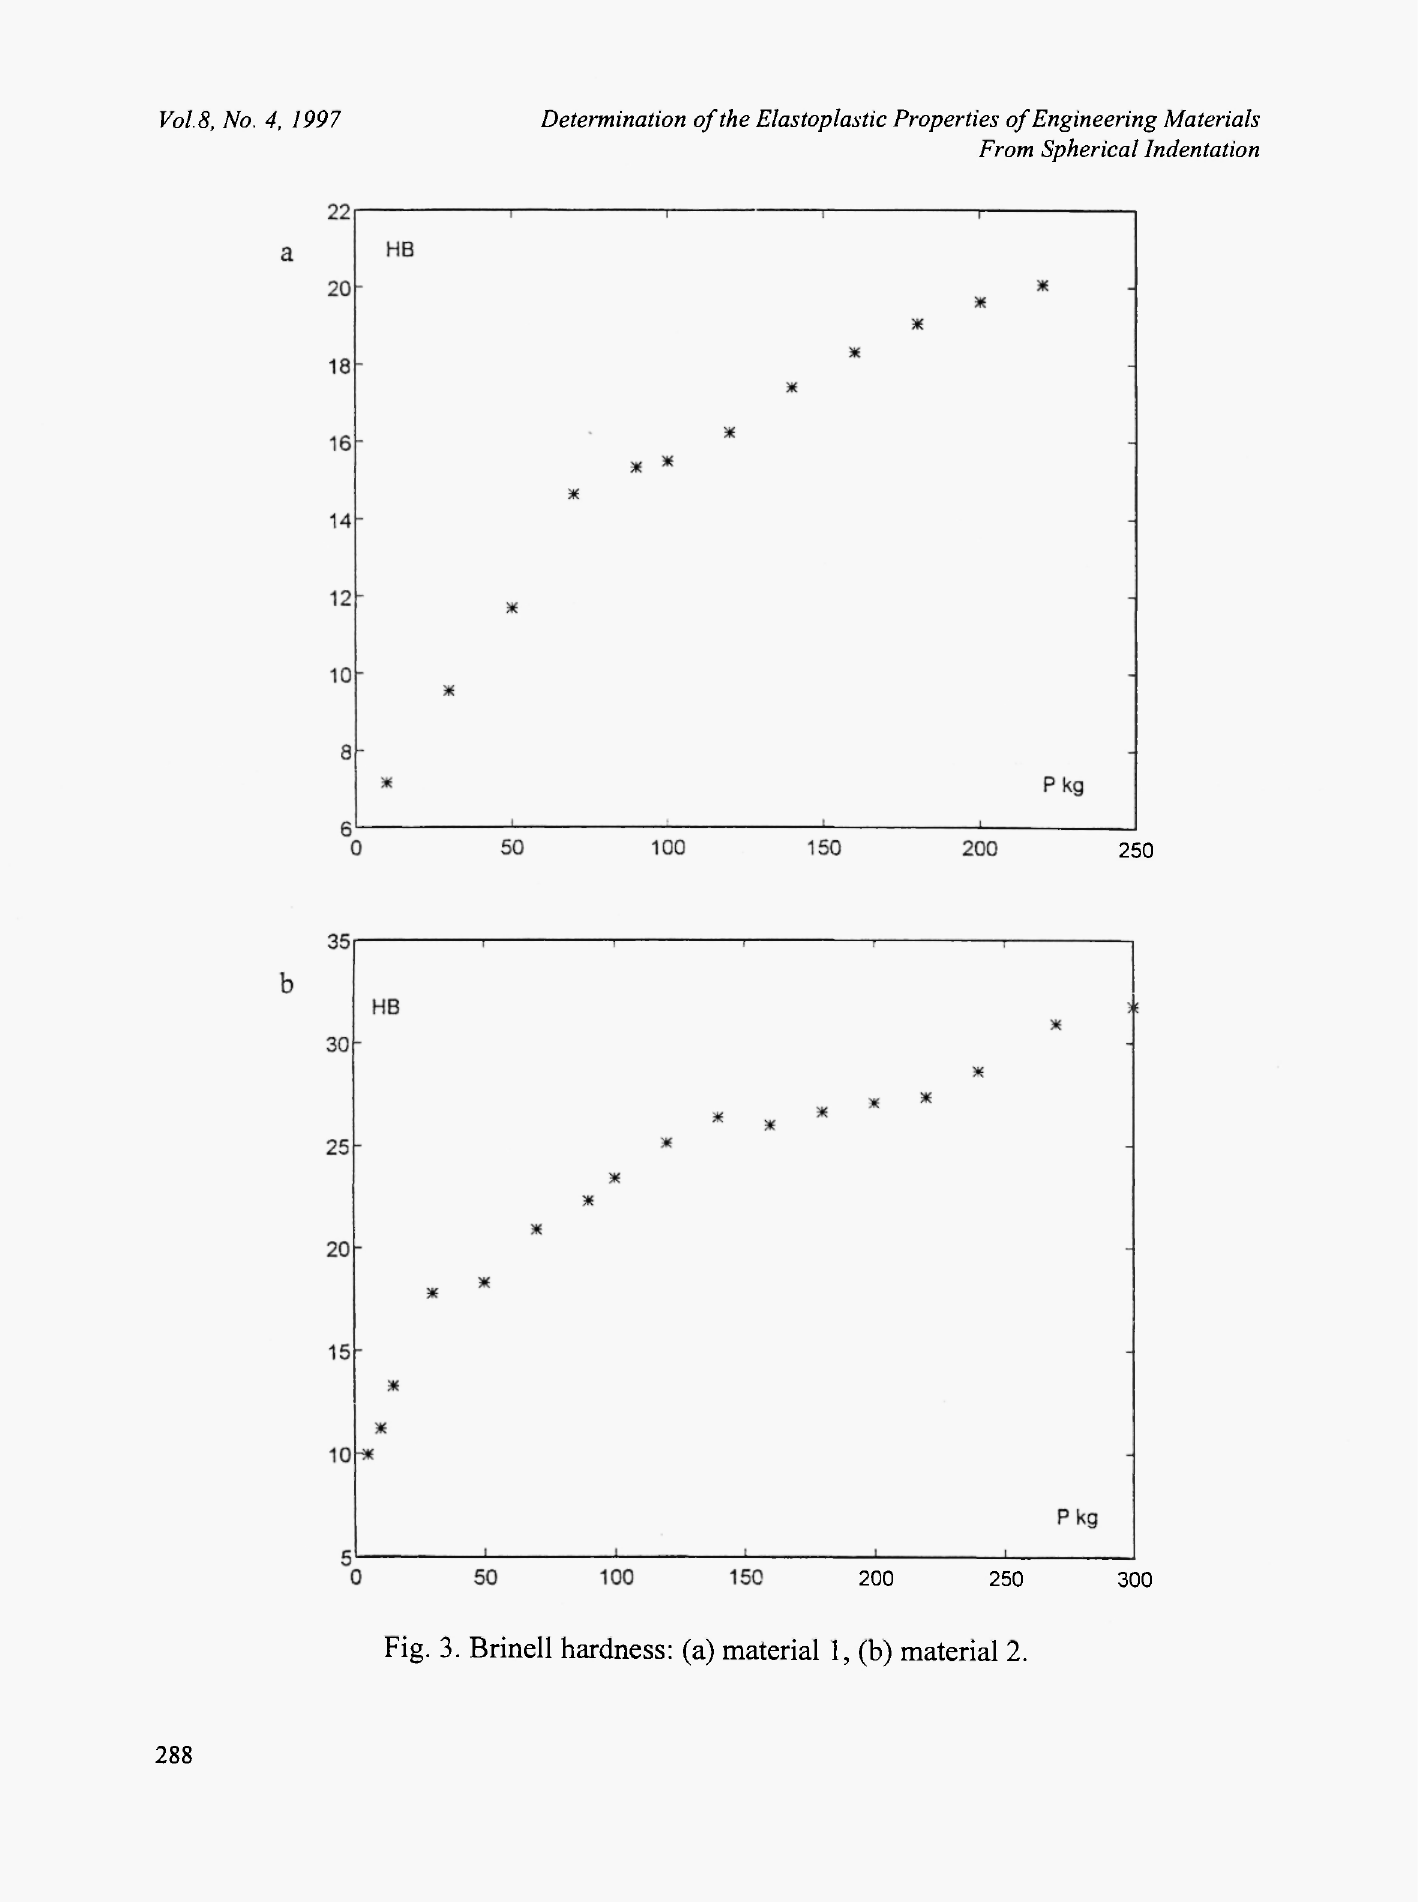
Fig. 3. Brinell hardness: (a) material 1, (b) material